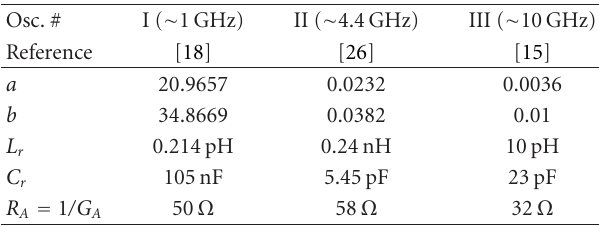
Table 2: Details on the general design